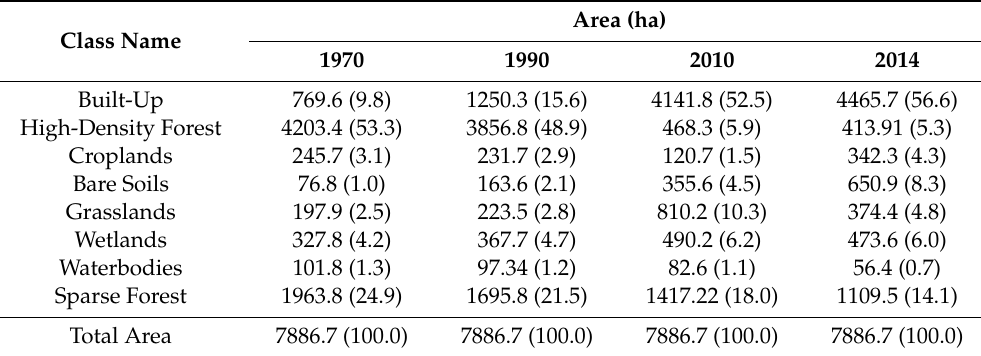
Table 3. The spatial extent of land use change after classification (ha).